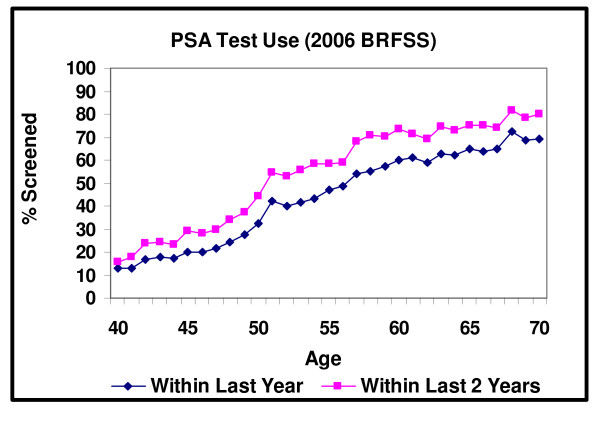
PSA Test Use within the Last 1 and 2 Years.